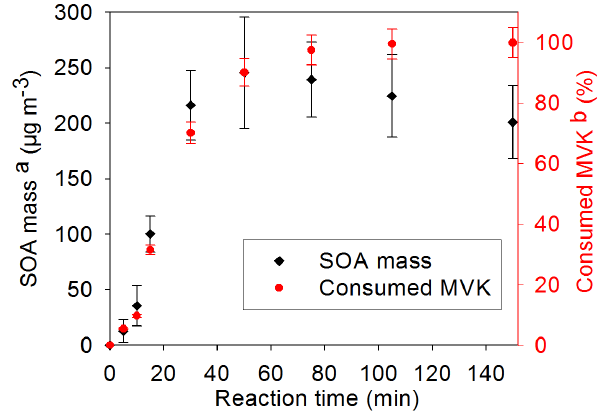
Figure 6. Time profiles of the total aerosol mass (black diamonds) from the nebulized solutions, and consumed MVK in the aqueous phase (red circles) for experiment B. (a) Values represent averages of three consecutive SMPS measurements for each reaction time considering the corresponding density (Table 1). Error bars repre- sent the sum of the standard deviation of these averages and the uncertainties of the density calculation. (b) % in concentration of MVK. These concentrations were determined by means of UHPLC- UV, with an uncertainty of ±